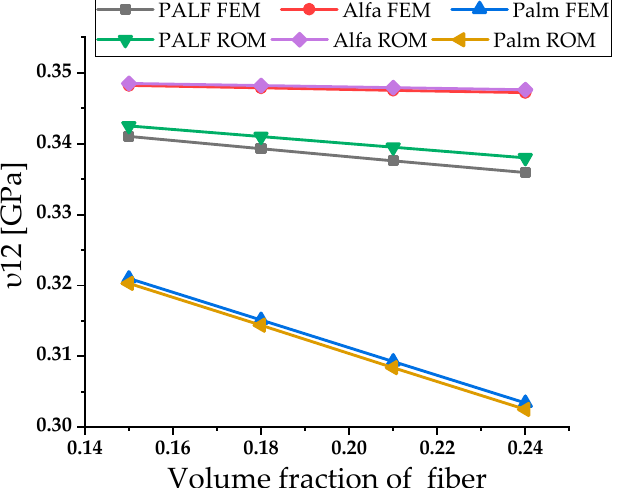
Figure 14. Predicted analytical (ROM model) and numerical results of Poisson’s ratios v 12 in terms of V F .